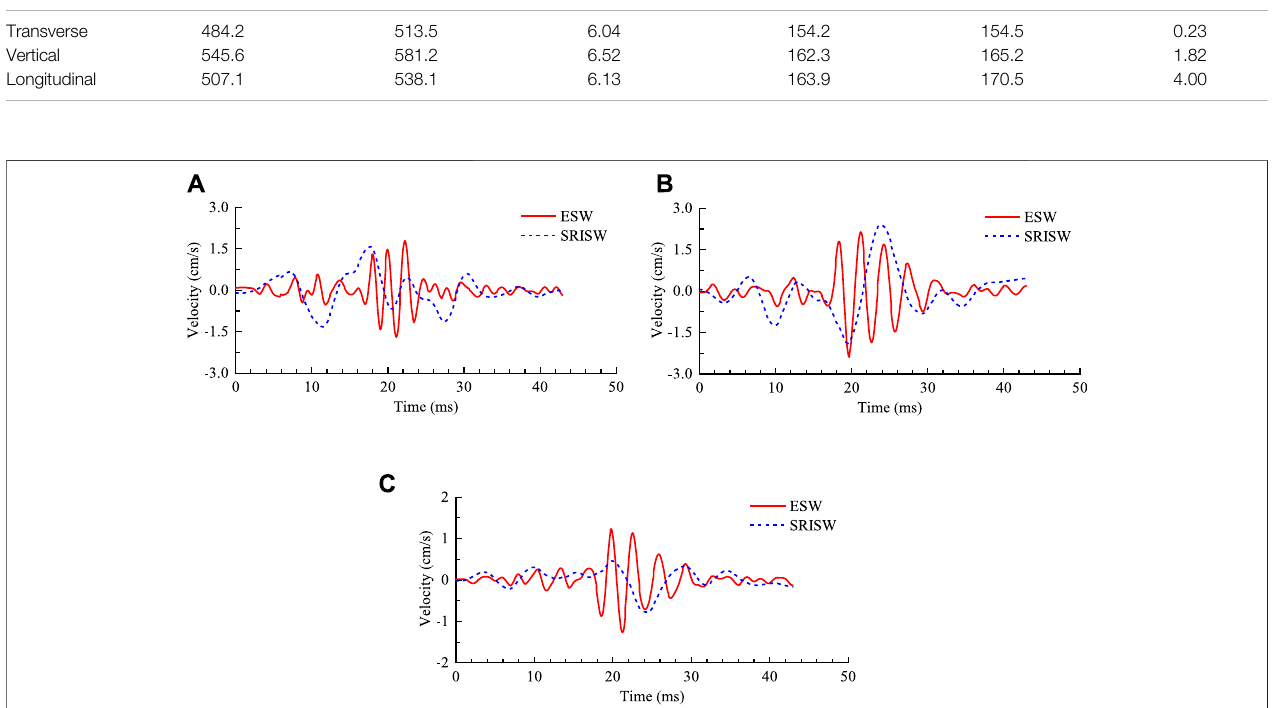
FIGURE 11 | Seismic waves separated from the monitored vibration signals. (A) Transverse component, (B) Vertical component, (C) Longitudinal component.